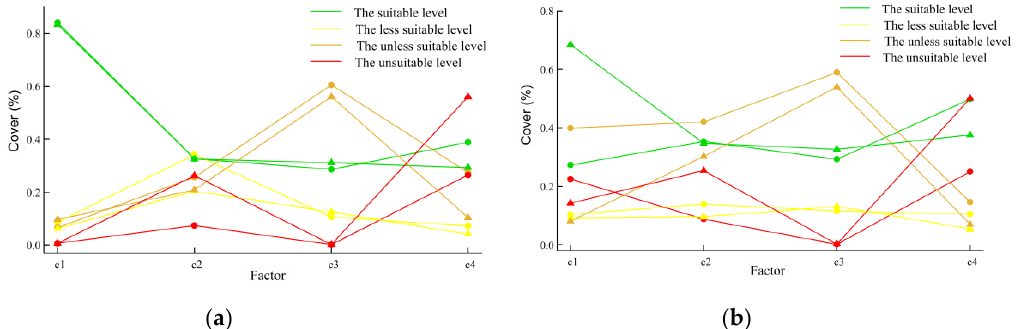
Figure 7. Percent habitat-level change per factor in Poyang Lake in the four scenarios; ● represents S1 in ( a ) and S2 in ( b ), and ▲ represents S3 in ( a ) and S4 in ( b ). S1: Wet year, no hydraulic project; S2: Dry year, no hydraulic project; S3: Wet year, hydraulic project present/operating; S4: Dry year, hydraulic project present/operating. ( a ) Percent habitat-level change between S1 and S3; ( b ) percent habitat-level change between S2 and S4.